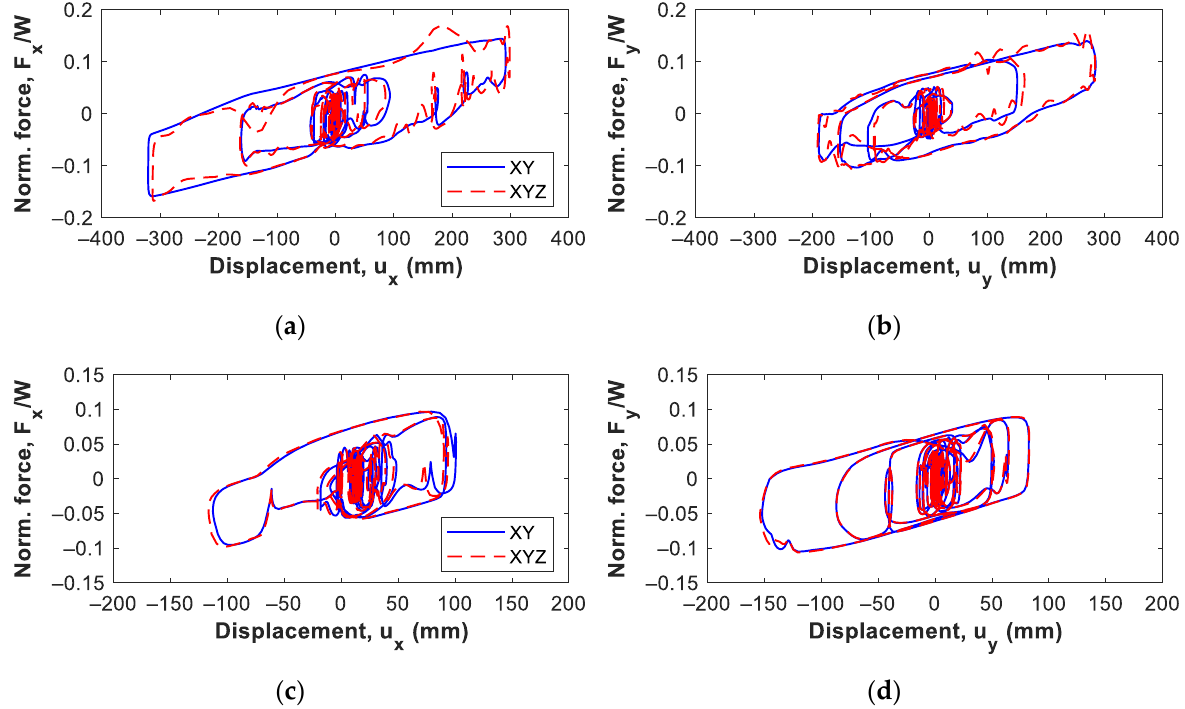
Figure 9 . Hysteresis loops under bi- and tri-directional excitations: ( a , b ) X- and Y-response of the near-source earthquake and ( c , d ) X- and Y-response of the far-field earthquake.